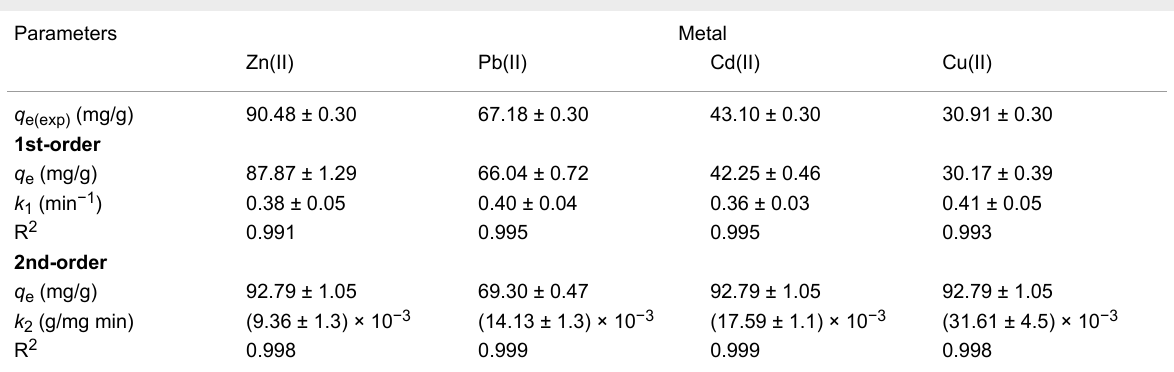
Table 1: Kinetics of heavy metal removal onto